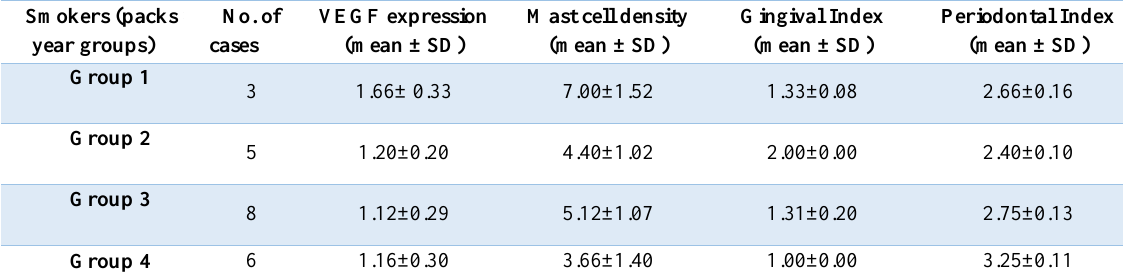
Table2. Mean VEGF expression, Mast Cell Density, Gingival Index and Periodontal Index Based on Packs × Year